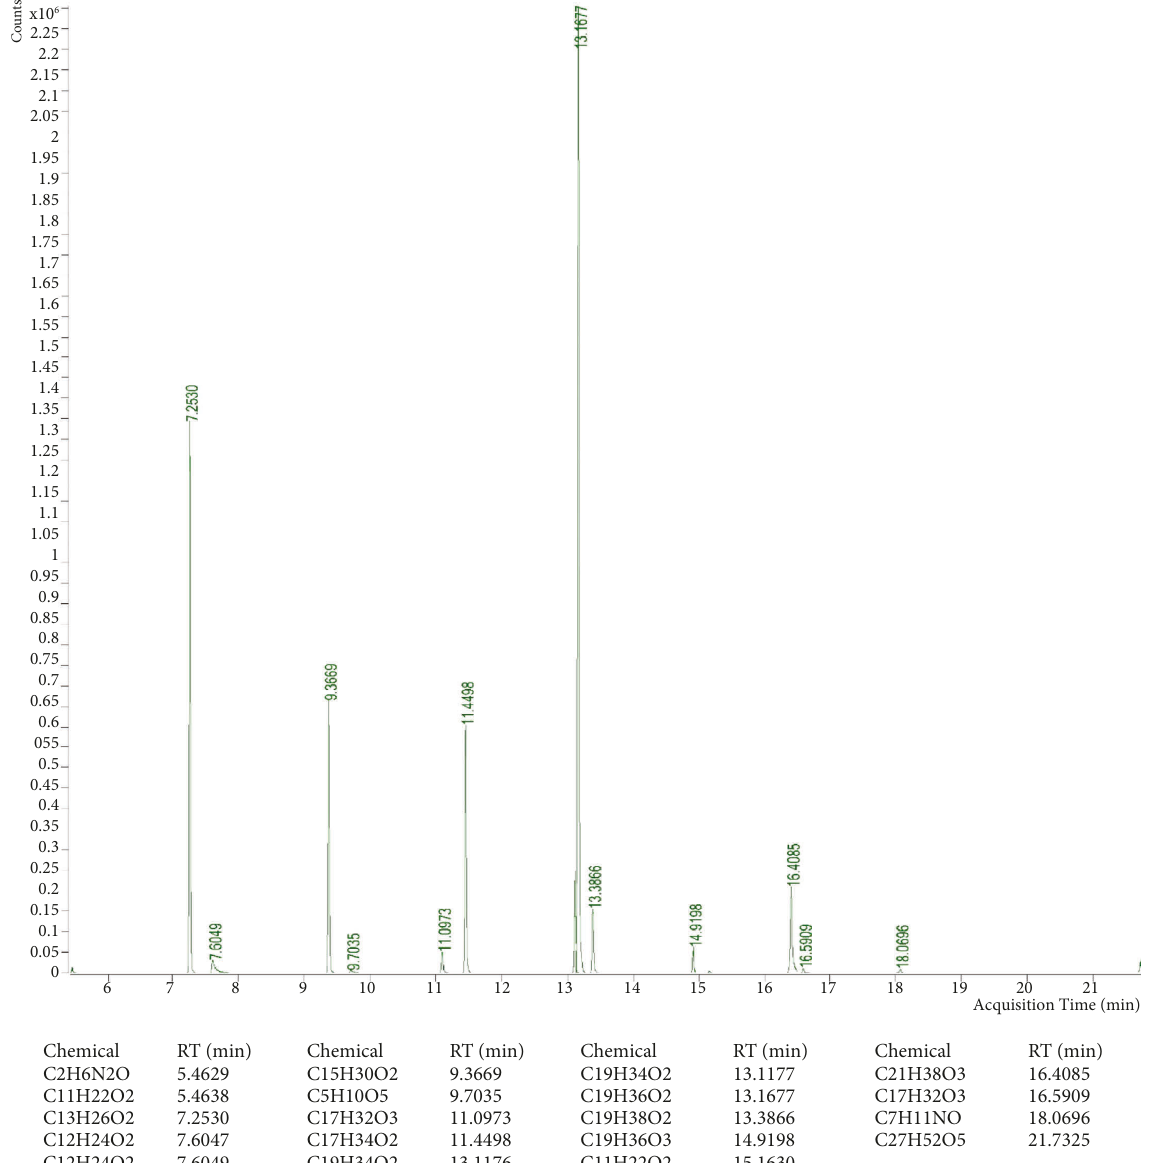
Figure 1: GC-MS chemical characterization of a lyophilized extract of date pits. RT: retention